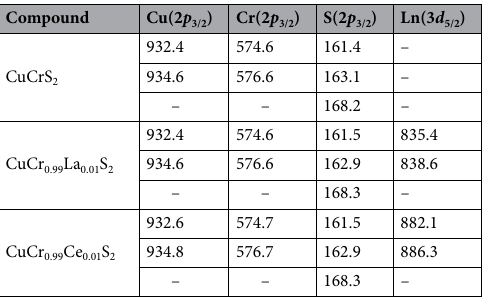
Table 1. Binding energies values (eV) of the XPS Cu(2 p 3/2 )-, Cr(2 p 3/2 )-, S(2 p 3/2 )-, La(3 d 5/2 )- and Ce(3 d 5/2 )- lines.